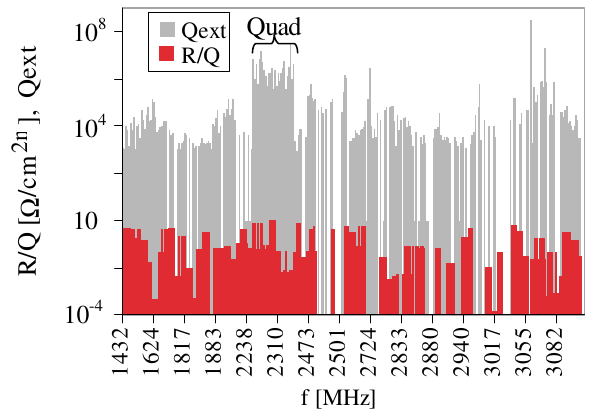
FIG. 14. (Color) Damping of modes with (cid:7) R=Q (cid:10) < 1 (cid:12) = cm 2 n